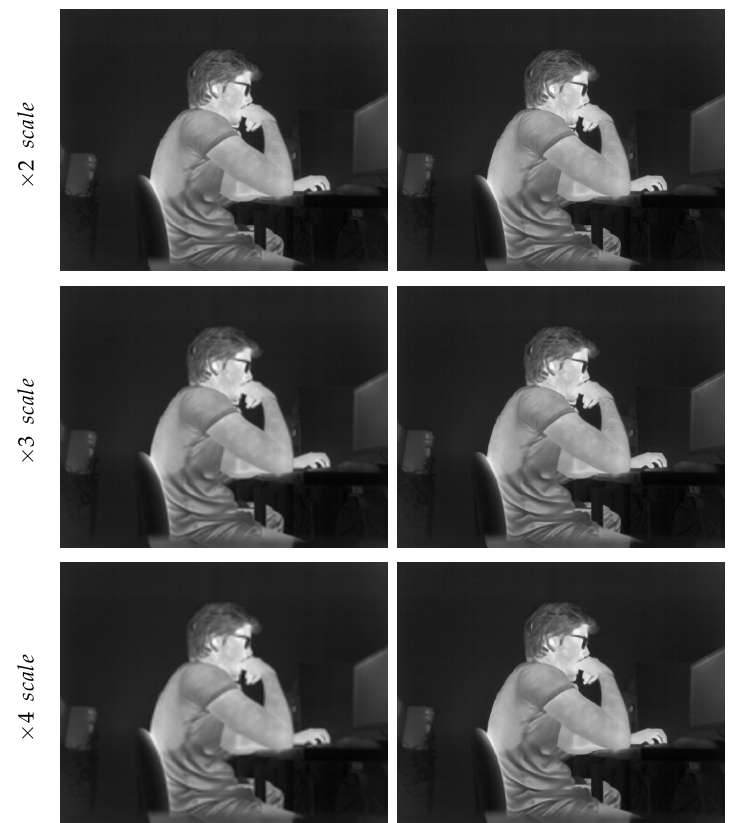
Figure 10. Results of our proposed network (left: low-quality input image; right: enhanced output